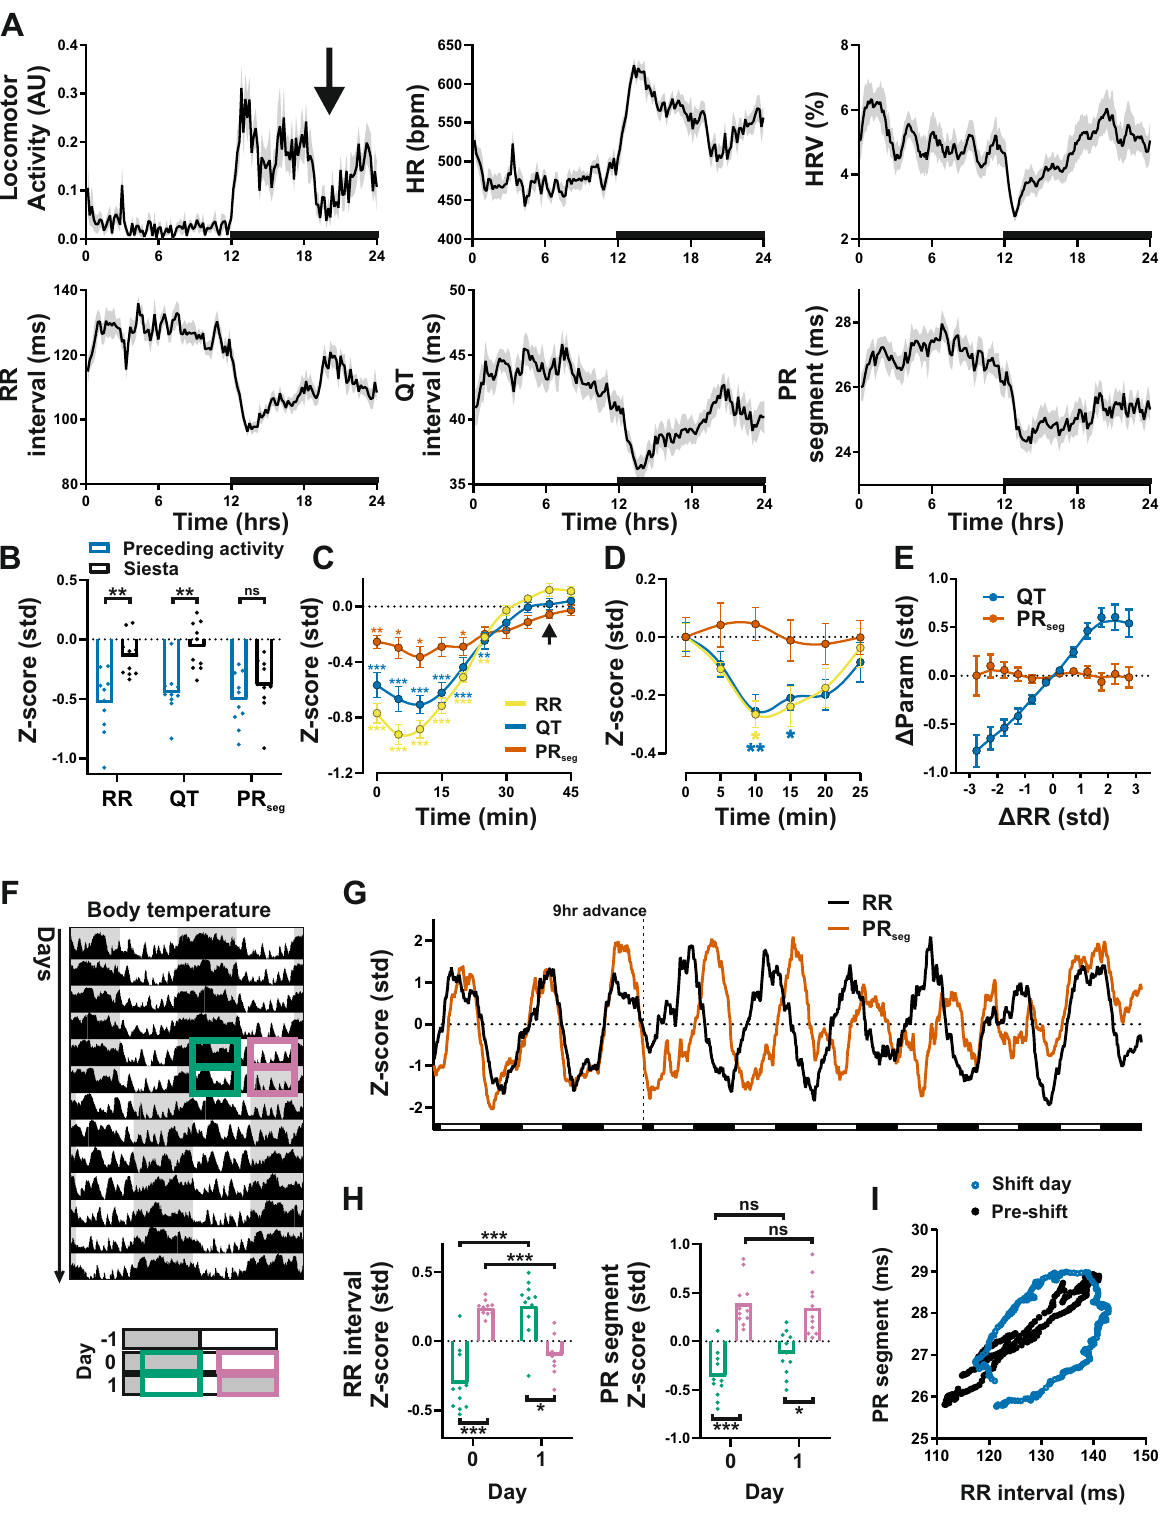
We next assessed the impact of an acute phase shift of the LD interval rhythms within individual mice (Fig. 3G) and across the cycle in mice, thereby mimicking the mistimed sleep and population mean (Fig. 3H, I). As evident in the body temperature simulated shift-work studies in humans. Here, mice were exposed pro fi le (Fig. 3F), the central circadian clock shows slow gradual to an abrupt 9 h advance in the LD cycle (Fig. 3F). This caused a adaption to the new LD schedule. That body temperature and rapid adjustment of the RR interval rhythm to the new timing PR seg interval rhythms exhibit similar shift dynamics (Supple- (Fig. 3G, H). By contrast, rhythms in PR seg were much slower to mentary Fig. 4) suggests that the AV node is similarly in fl uenced adapt, leading to a temporary misalignment of RR and PR seg by a central clock mechanism. Thus, despite mice and humans NATURE COMMUNICATIONS| (2021)